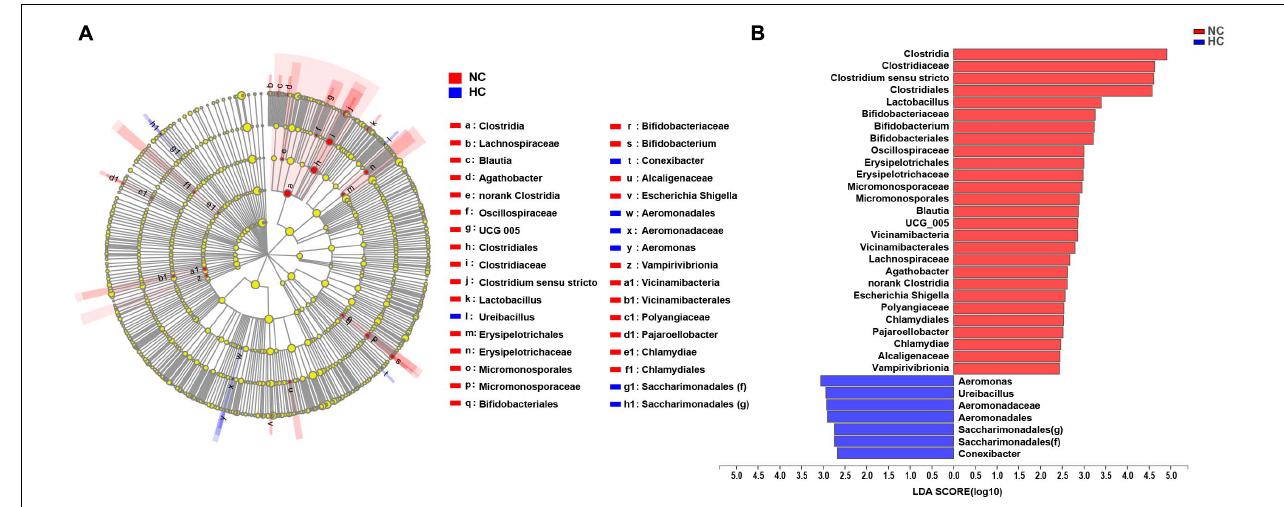
FIGURE 3 | LEfSe analysis of the differences in the intestinal microbiota of largemouth bass fed two diets (A) Taxonomic representation of differences in the intestinal microbiota of largemouth bass treated with the NC or HC diets. The concentric circles from the inside out represent the different taxonomic classes (phylum to genus). The different colored nodes indicate differences in intestinal microbiota (red represents a significantly higher abundance of intestinal microbiota in the NC treatment than in the HC treatment, while blue represents the opposite, and yellow indicates no significant difference). The size of each node indicates the abundance of intestinal microbiota. (B) Histogram of linear discriminant analysis (LDA) scores for differential abundance of the intestinal microbiota.